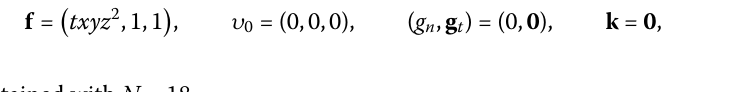
which correspond to the data of the homogeneous boundary conditions (cid:9) (cid:10) f = txyz 2 ,1,1 , υ 0 = (0,0,0), ( g n , g t ) = (0, 0 ), k = 0 , (39) obtained with N =